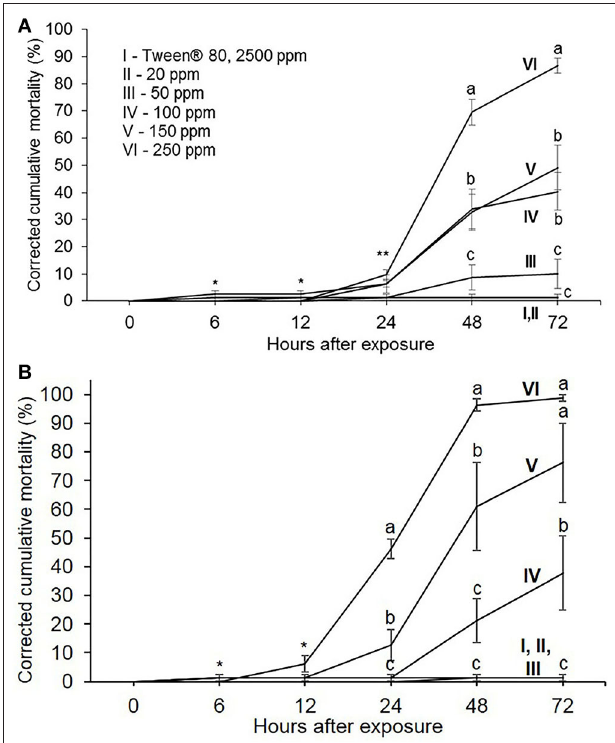
FIGURE 1 | Corrected cumulative mortality (%) of Meloidogyne luci second-stage juveniles exposed to different concentrations of juglone (JUG, A ) and 1,4-naphthoquinone (1,4-NTQ, B ). Data are an average of four replicates, and bars represent standard errors. Average followed by the same lower case, at the same exposure time, do not differ significantly ( p > 0.05) according to the Fisher’s LSD test. * At 6 and 12h after exposure, no significant differences were found. ** IV and VI were significantly different from I, II, and III; V does not differ significantly from all treatments.